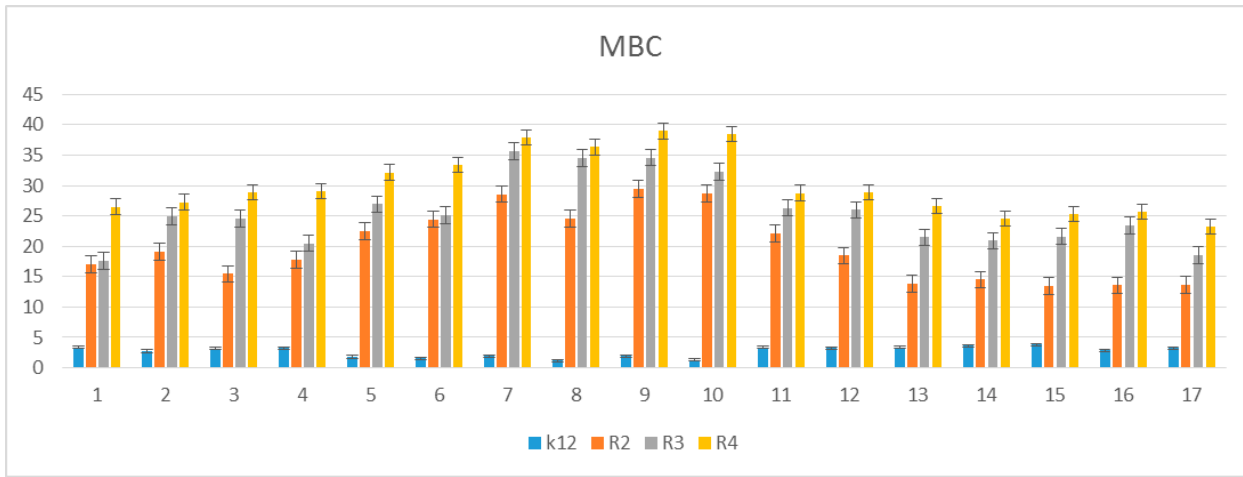
Figure 5. MBC of the lactones in model bacterial strains. The x -axis compounds 1–17 were used sequentially. The y -axis shows the MBC value in µg/mL − 1 .